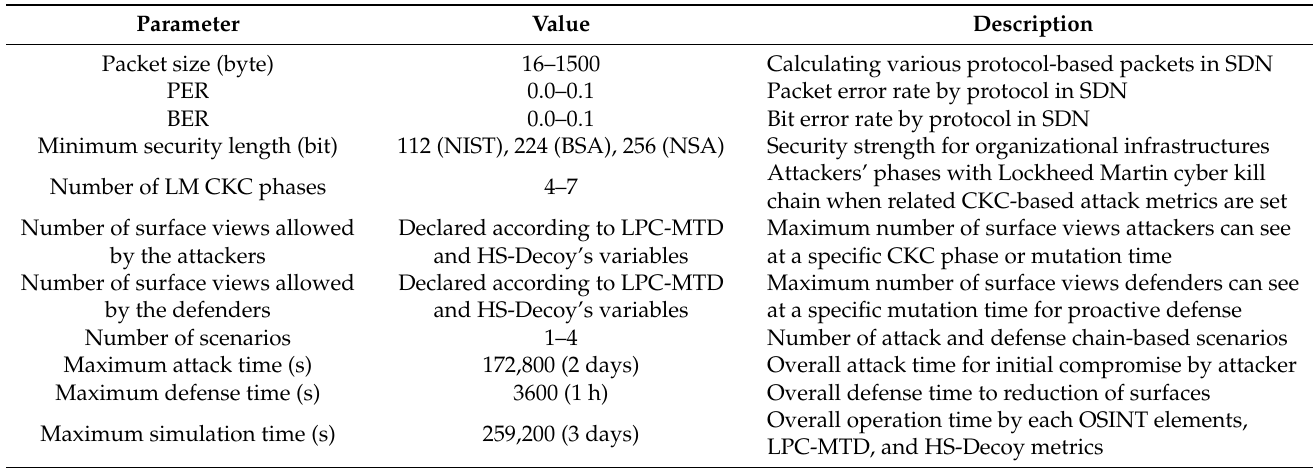
Table A4. Configuration of communication and simulation parameters in SDN-based testbeds.